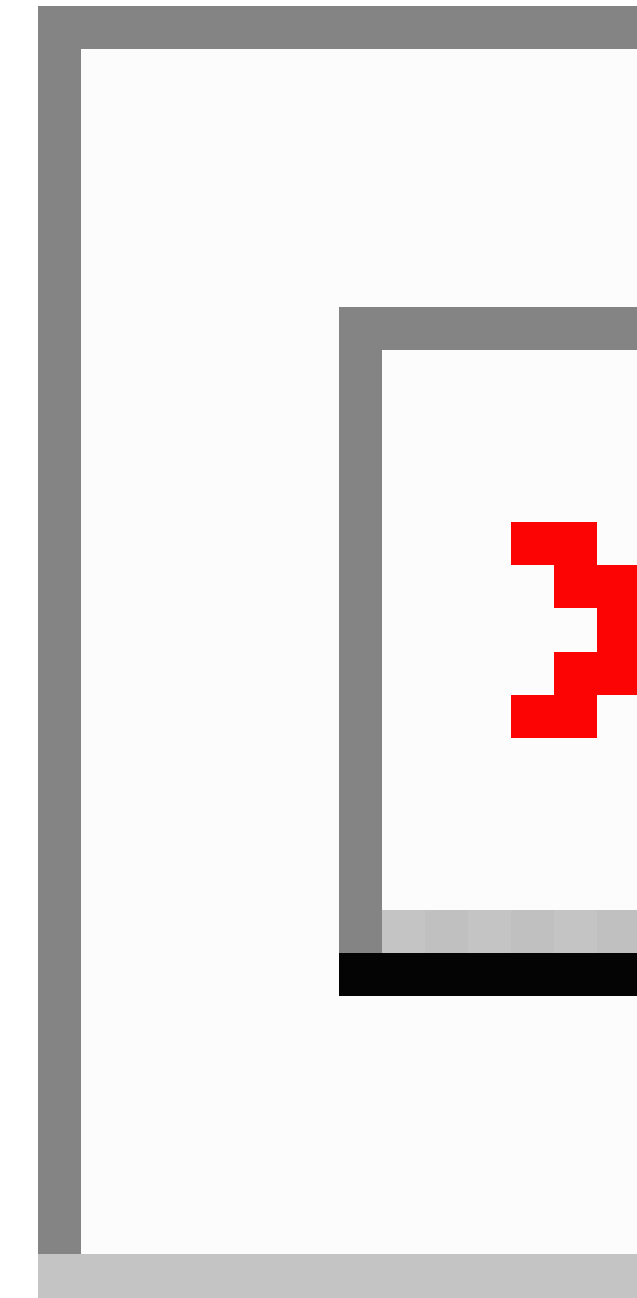
Figure 1. The AppSalut Site recommendation